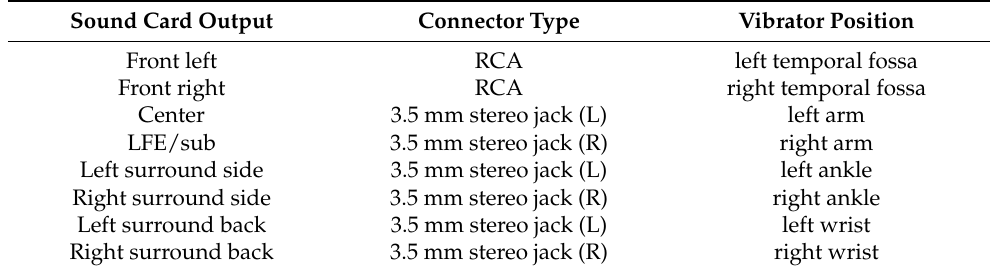
Table 1. Sound card output connectors with the corresponding wiring solutions and transducer placements.